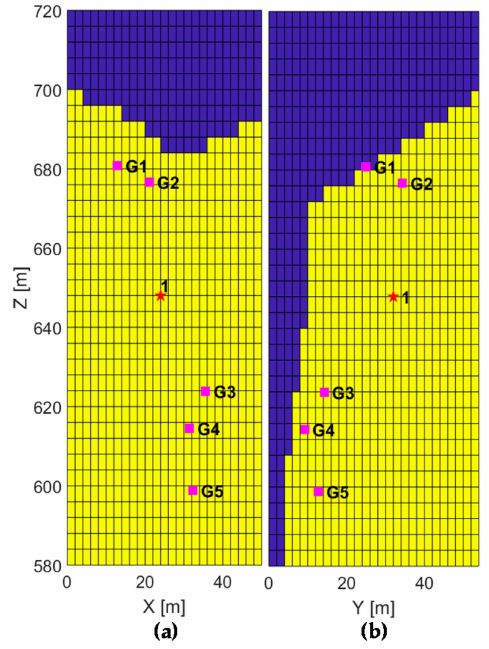
Figure 12. Location results for Fracture event 1 (Fracture) presented on vertical slices in the front view ( a ) and side view ( b ). The blue area is the air, and the yellow area is rock mass. Pink squares indicate the five 3C geophones projected on the slice. Red stars indicate the event locations projected on the slice. Both slices cross the event location.